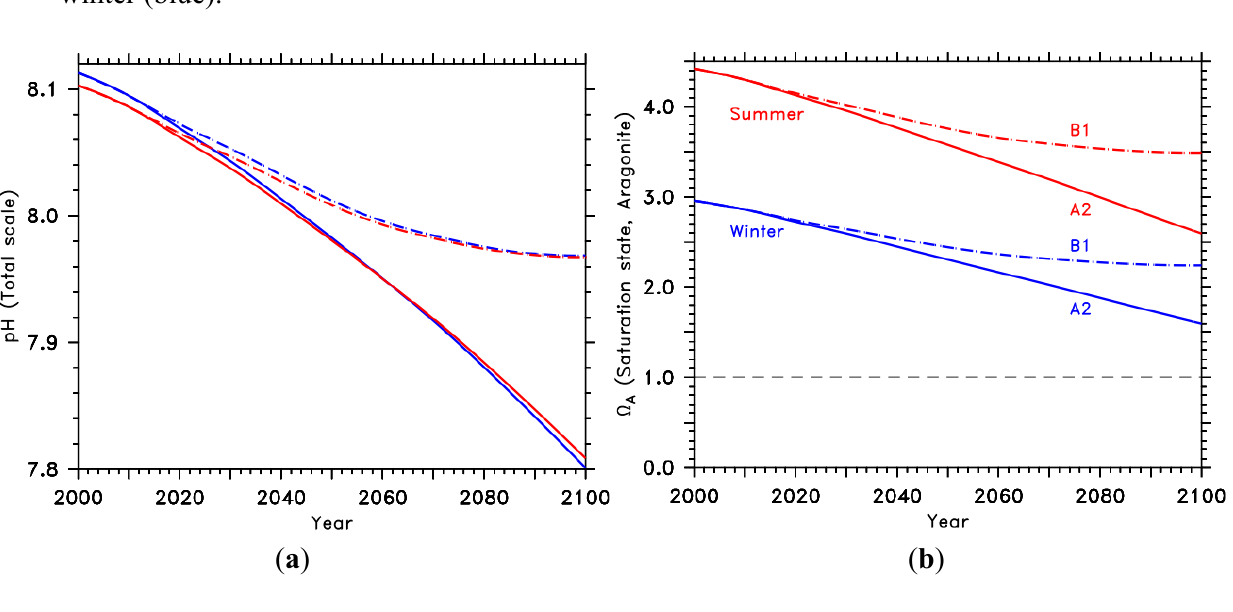
Figure 2. Surface-water pH ( a ) and saturation state with respect to aragonite ( b ) during the 21st century projected for the business-as-usual IPCC scenario A2 (solid line) and the more conservative B1 scenario (dashed line) under typical conditions for summer (red) and winter